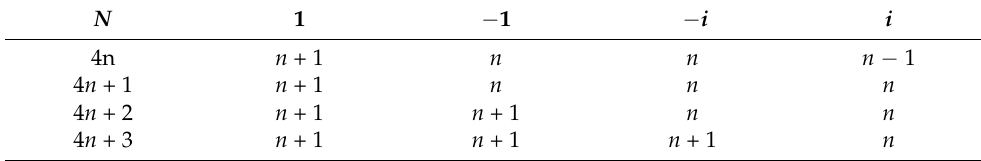
Table 1. Multiplicities of the DFT